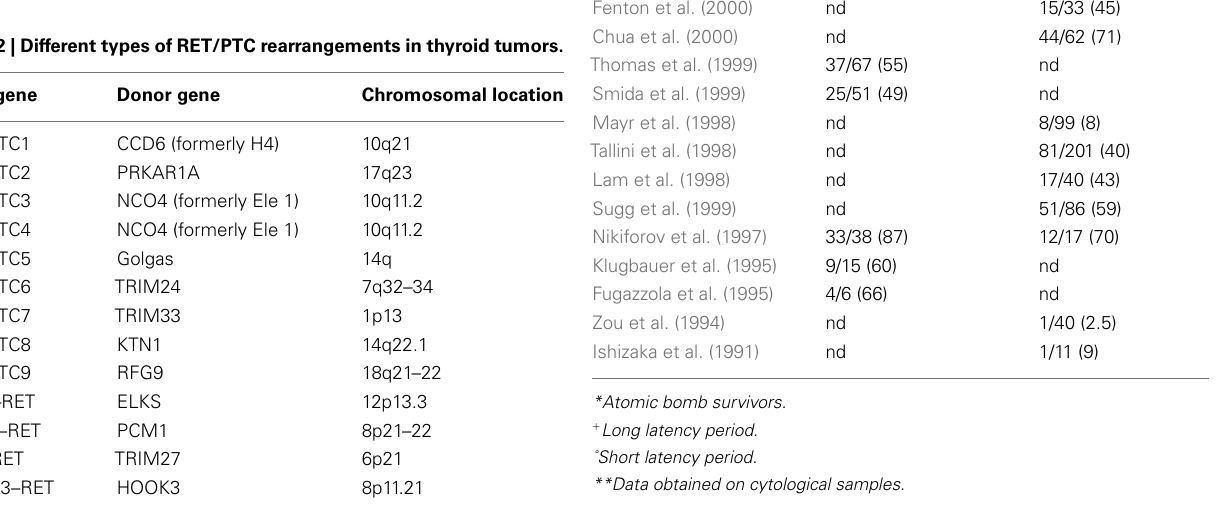
FIGURE 2 | Schematic representation of RET /PTC1 rearrangement: a centromeric inversion of chromosome 10 (A) generates a chimeric gene through the fusion of the RET tyrosine-kinase domain with the 5 (cid:2) terminal region of a new gene denominated CCD6, formerly called H4 (B).